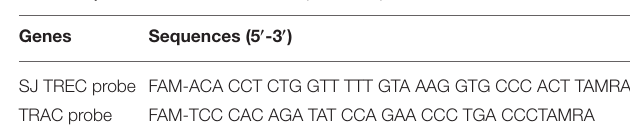
TABLE 2 | Quantitative real-time PCR probe sequences.